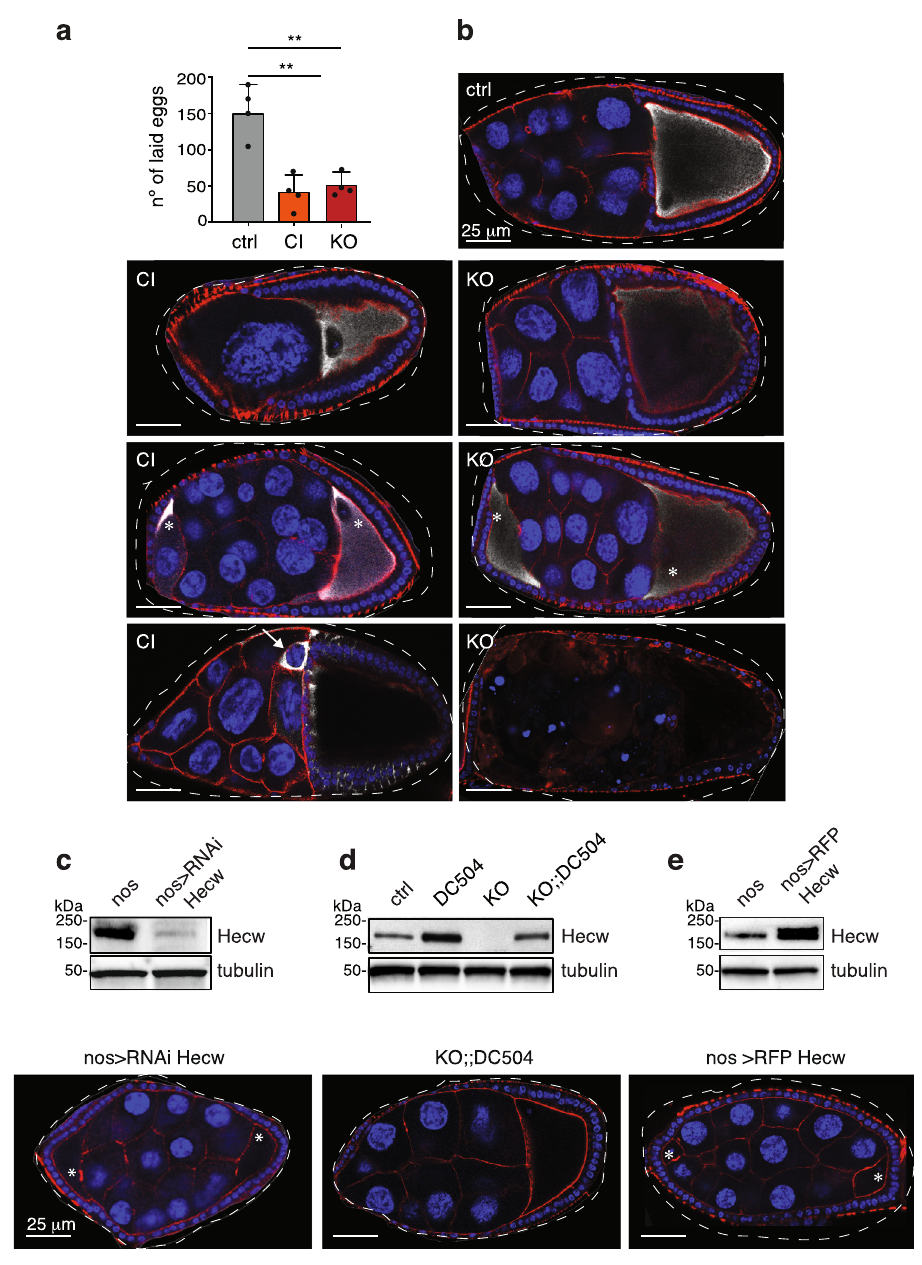
Fig. 3 Aberrant expression of Hecw impairs proper oogenesis. a Fertility assay of 20-day-old females of the indicated genotypes. Results of four biological replicates are expressed as mean ± SD, ** P < 0.01 by unpaired two-tailed t -test ( n = 6 females/genotype/replicate). b IF analysis of wild-type (ctrl, upper right panel), Hecw CI (CI, left panels) and Hecw KO (KO, right panels) egg chambers. Mutants show aberrant number of nurse cells (top panels), compound egg chambers (middle panels), oocyte misspeci fi cation and apoptotic egg chambers (bottom panels). Blue, DAPI; red, phalloidin; white, Orb; asterisks indicate oocytes in compound egg chambers; white arrow indicates an Orb-positive nurse cell. Scale bar: 25 µ m. c – e IB and IF analysis of the indicated genotypes. Hecw depletion in the germline causes oogenesis defects, as in ( b ), upper panel. Example of compound egg chamber in a 3-day-old Hecw- depleted fl y ( nos>RNAi Hecw ) ( c ). The oogenesis defects are rescued in the Hecw KO:DC504 genetic background ( d ). Ectopic expression of Hecw in the germline ( nos>RFP-Hecw ) induces oogenesis defects ( e ). Blue, DAPI; red, phalloidin. Asterisks indicate oocytes of the compound egg chamber. Scale bar: 25 µ m. See also Supplementary Table 1 for the quanti fi